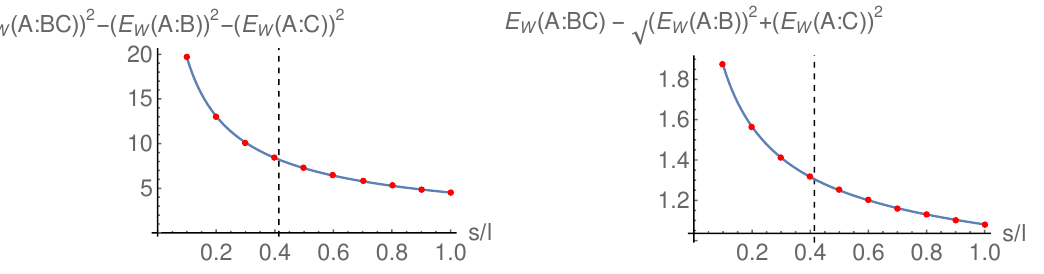
Figure 9 . Left : ( E W ( A : BC )) 2 − ( E W ( A : B )) 2 − ( E W ( A : C )) 2 for different s/l ratios. Right : p ( E W ( A : BC ) − E W ( A : B )) 2 + ( E W ( A : C )) 2 for different s/l ratios. For both the plots, analytic result is depicted by a solid curve and the numerical result is shown by red dots. Bipartite critical points at s/l ≈ 0 . 414 are indicated by dashed lines in the